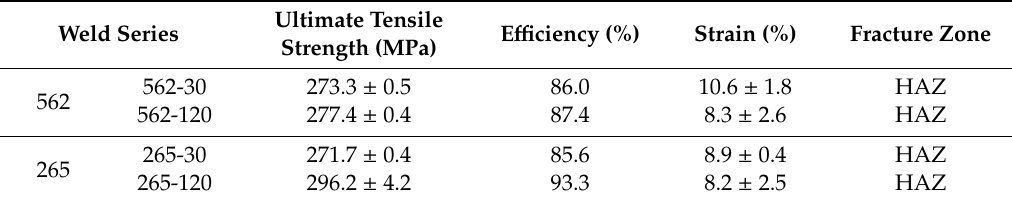
Figure 11. Effect of variation of the welding speed on the hardness profile in the ( a ) skin and ( b ) stringer. Table 5. Average tensile results of defect-free welded